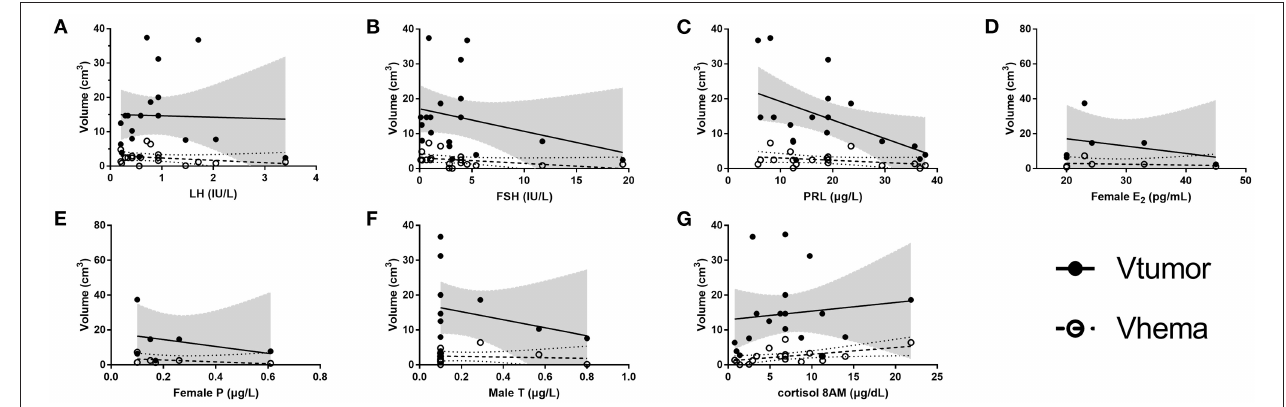
FIGURE 3 | Correlation between the tumor/ hematoma volumes and the hormones. (A) LH, (B) FSH, (C) PRL, (D) female E 2, (E) female P, (F) male T, and (G) Cortisol 8AM. E2, estradiol; FSH, follicle stimulating hormone; LH, luteinizing hormone; P, progesterone; PRL, prolactin; T, testosterone; Vhema, the volume of the hematoma; Vtumor, the volume of the tumor. The values of r and p of V tumor for hormones are: LH ( r = − 0.0313, p = 0.902), FSH ( r = − 0.2868, p = 0.249), PRL ( r = − 0.5114, p = 0.030), female E 2 ( r = − 0.3306, p = 0.522), female P ( r = − 0.3091, p = 0.551), male T ( r = − 0.2579, p = 0.418), and cortisol 8AM ( r = 0.1223, p = 0.629). The r values and p of V hema for hormones are: LH ( r = − 0.2848, p = 0.252), FSH ( r = − 0.3831, p = 0.117), PRL ( r = − 0.3439, p = 0.162), female E 2 ( r = − 0.1999, p = 0.704), female P ( r = − 0.4386, P = 0.384), male T ( r = − 0.1151, p = 0.722), and cortisol 8AM ( r = 0.5155, p = 0.029). Gray shadow and dotted curves represent the 95% confidence bands of the best-fit line for the volume of the tumor and the hematoma,